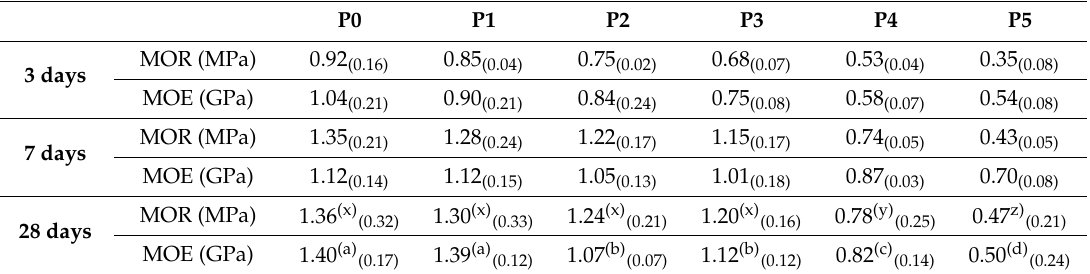
Table 5. Average bending strength test results of wood-cement-ash particleboards (WCAP). Mean values with the same superscript are not significantly di ff erent for p = 0.05; standard deviation is given in